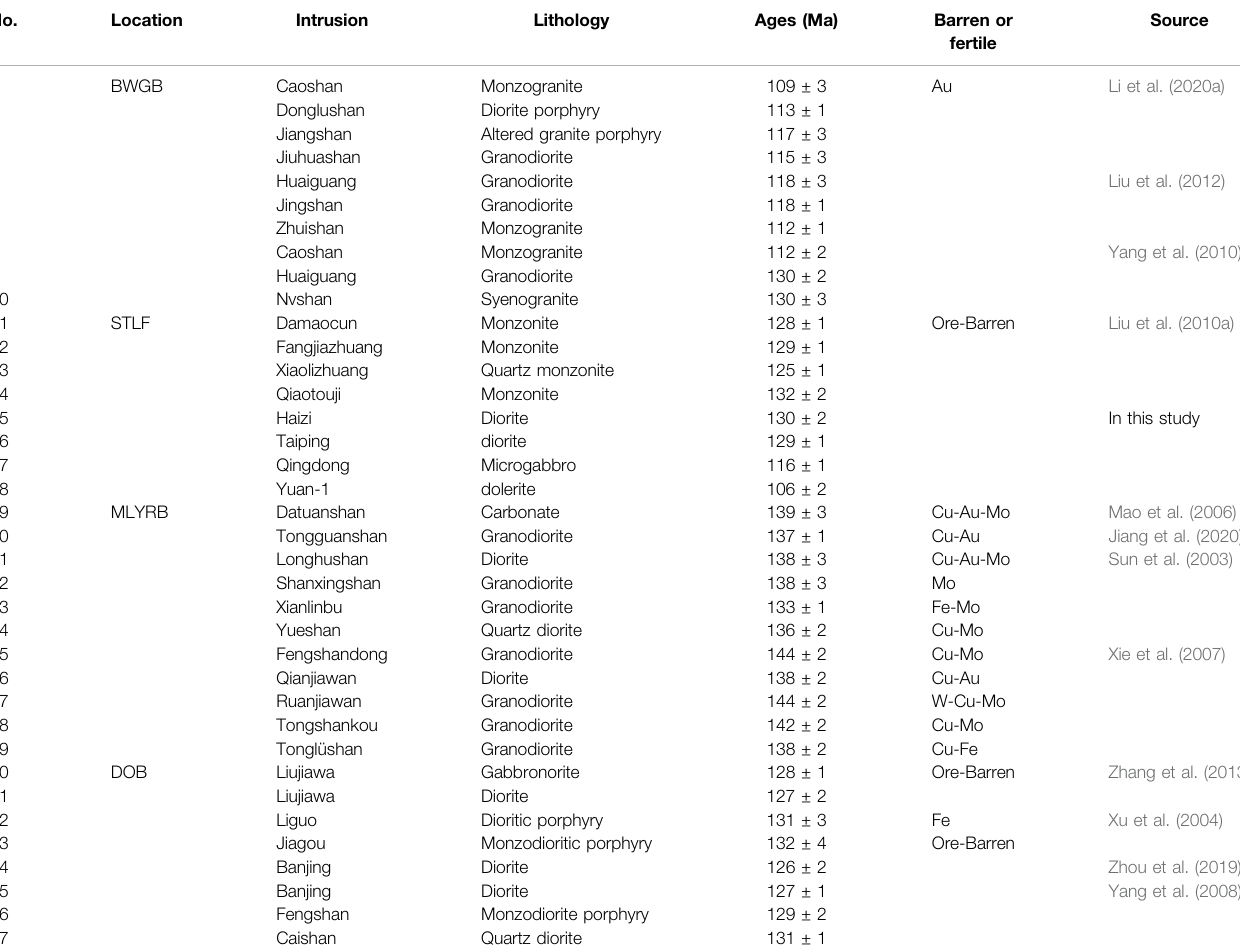
TABLE 1 | Summary of ages, intrusions and lithology of major barren and fertile adakite units in Eastern